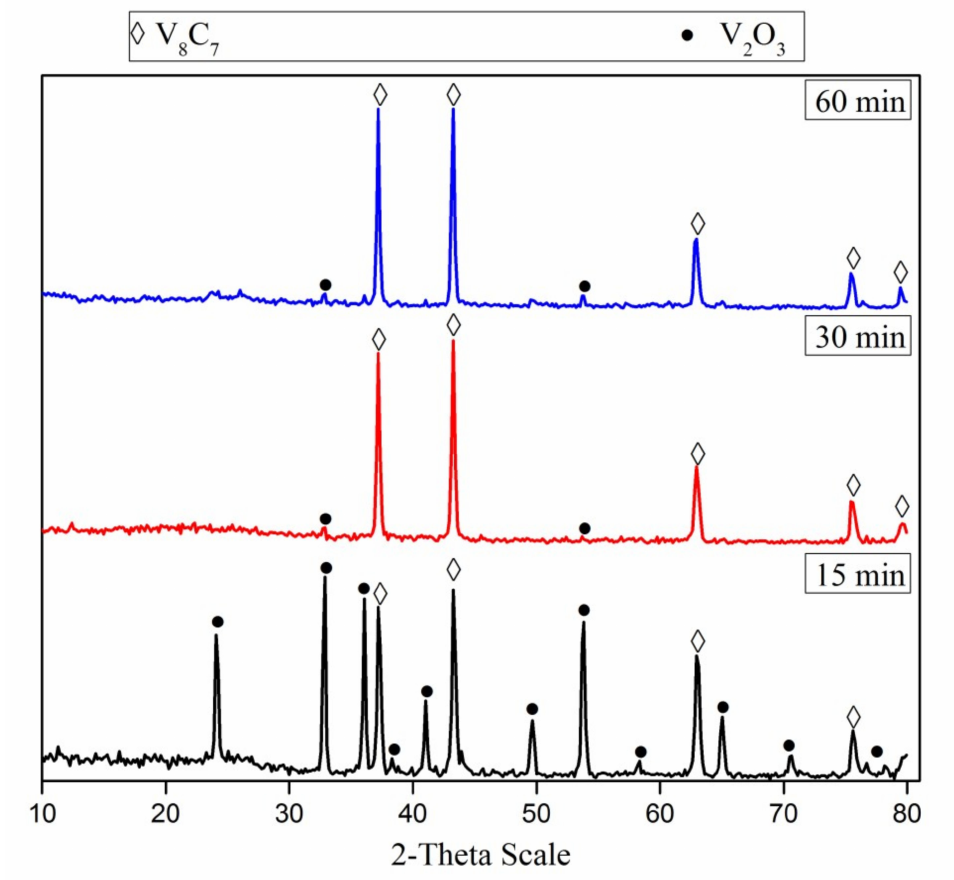
Figure 4. XRD patterns of 15 h mechanically activated V 2 O 5 -C mixture reduction products at 1050 ◦ C for di ff erent reduction